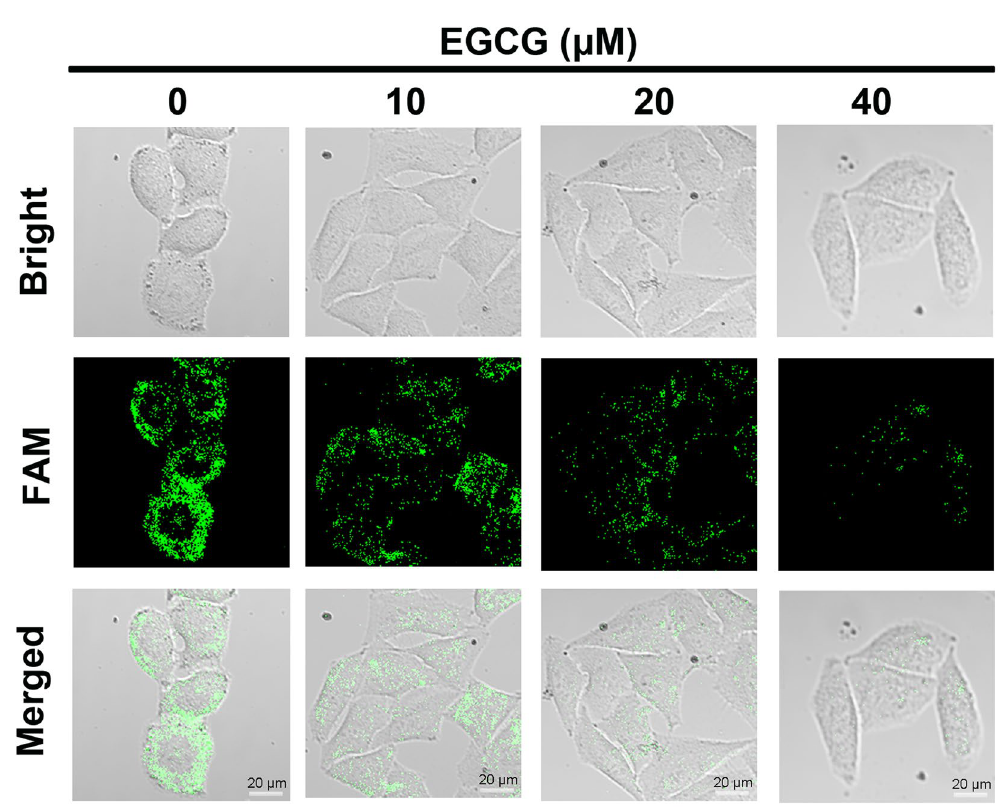
Figure 5. Confocal images of HeLa cells after incubation with different concentrations of EGCG (0 μ M, 10 μ M, 20 μ M, or 40 μ M) for 24 h, and then incubated with 100 μ L 1.2 nM AuNP-MPs for 2